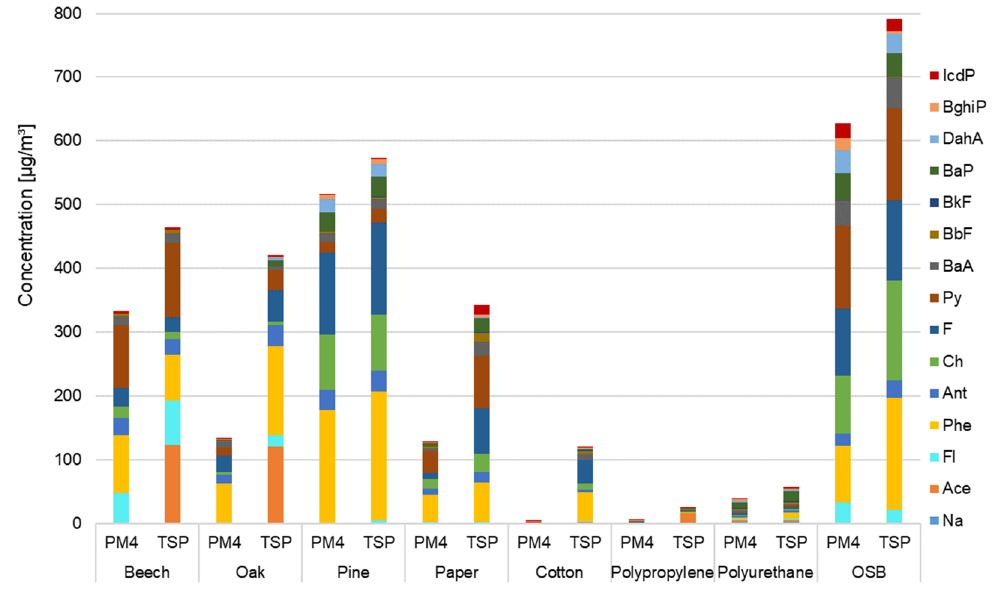
Figure 4. Concentration of 15 polycyclic aromatic hydrocarbons (PAHs) ( µ g / m 3 ) related to respirable fraction (PM 4 ) and total suspended particles (TSPs) during burning of various types of materials ( r = 0.944, p <